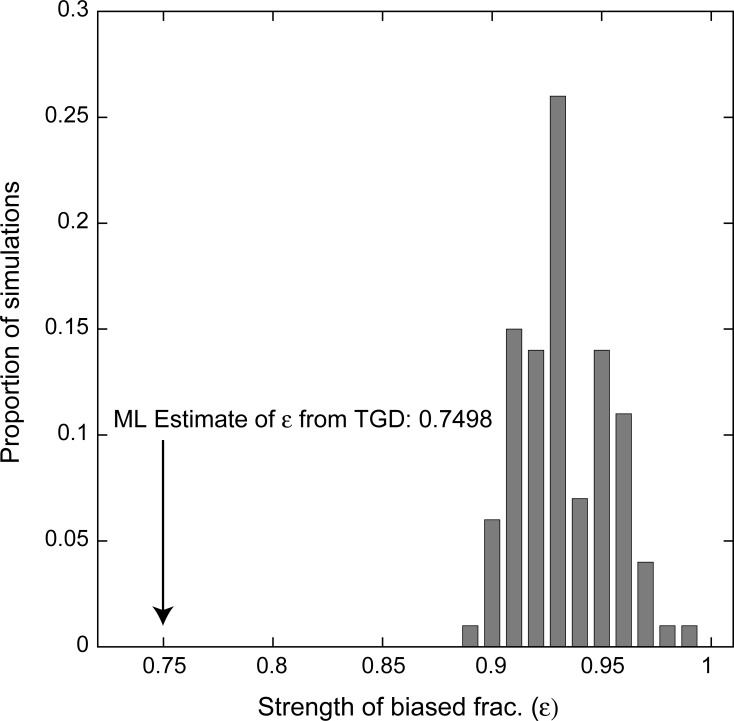
The estimated value of the biased fractionation parameter ε in the real teleost genomes (WGD-bf model, arrow, see Methods) is significantly different than those estimated from simulated genomes where biased fractionation was explicitly not included in the model (e.g., simulated ε = 1.0, bars).Estimates of ε from these 100 simulations are always less than 1.0 because the model fits stochastic variations in the preservation patterns as potential biased fractionation. However, this stochastic variation never yields estimates of ε as small as seen in the real dataset (P<0.01).